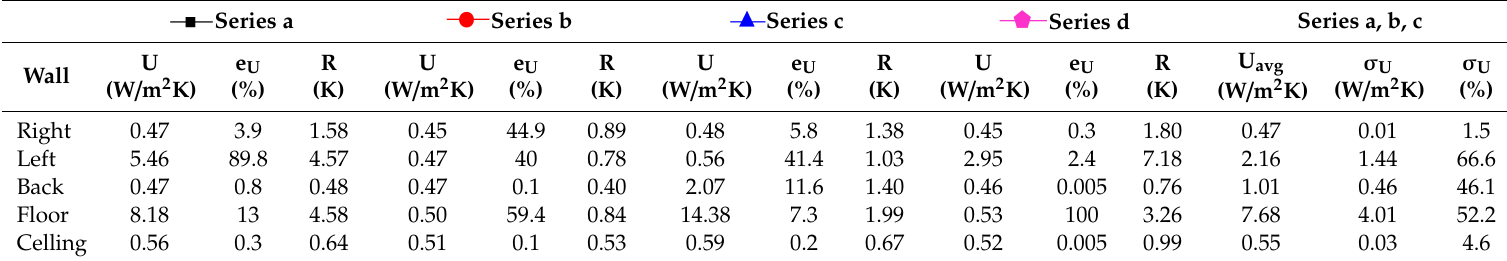
Table 7. Opaque walls. U value. Summary of the results using models that include solar radiation. Output: T i . Where e g is the error and R is the average of the residuals given by LORD for each data series.